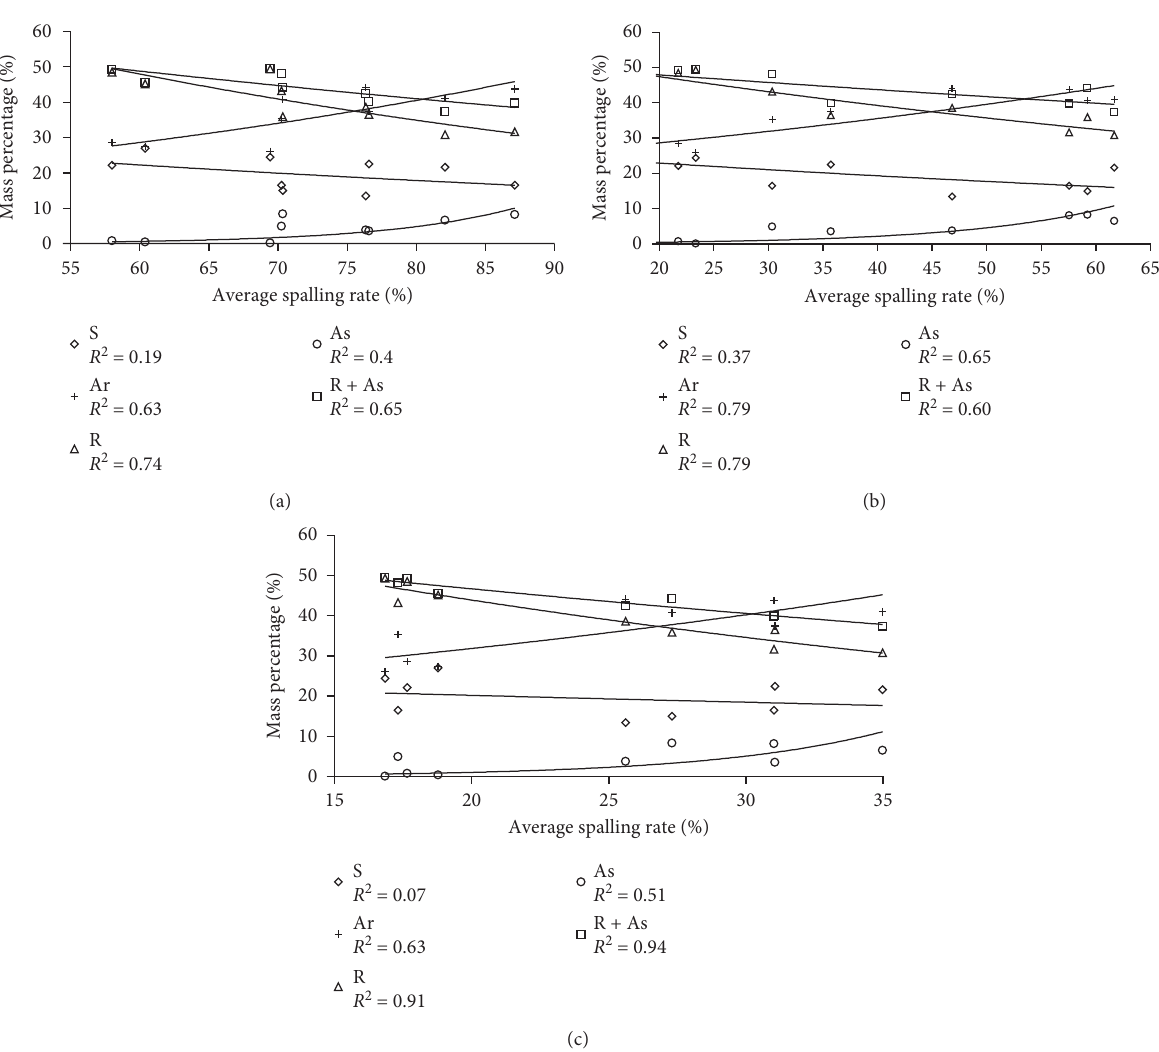
Figure 12: Effect of asphalt composition on the adhesion level between the aggregate and asphalt: (a) granite; (b) basalt; (c) limestone. R 2 =